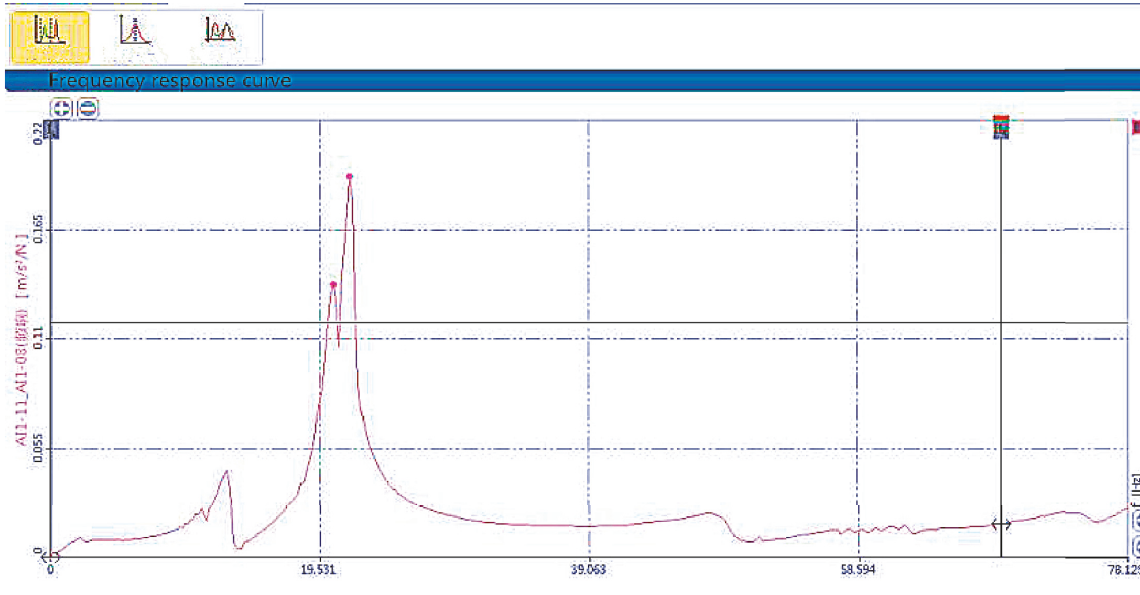
Figure 11: Frequency band